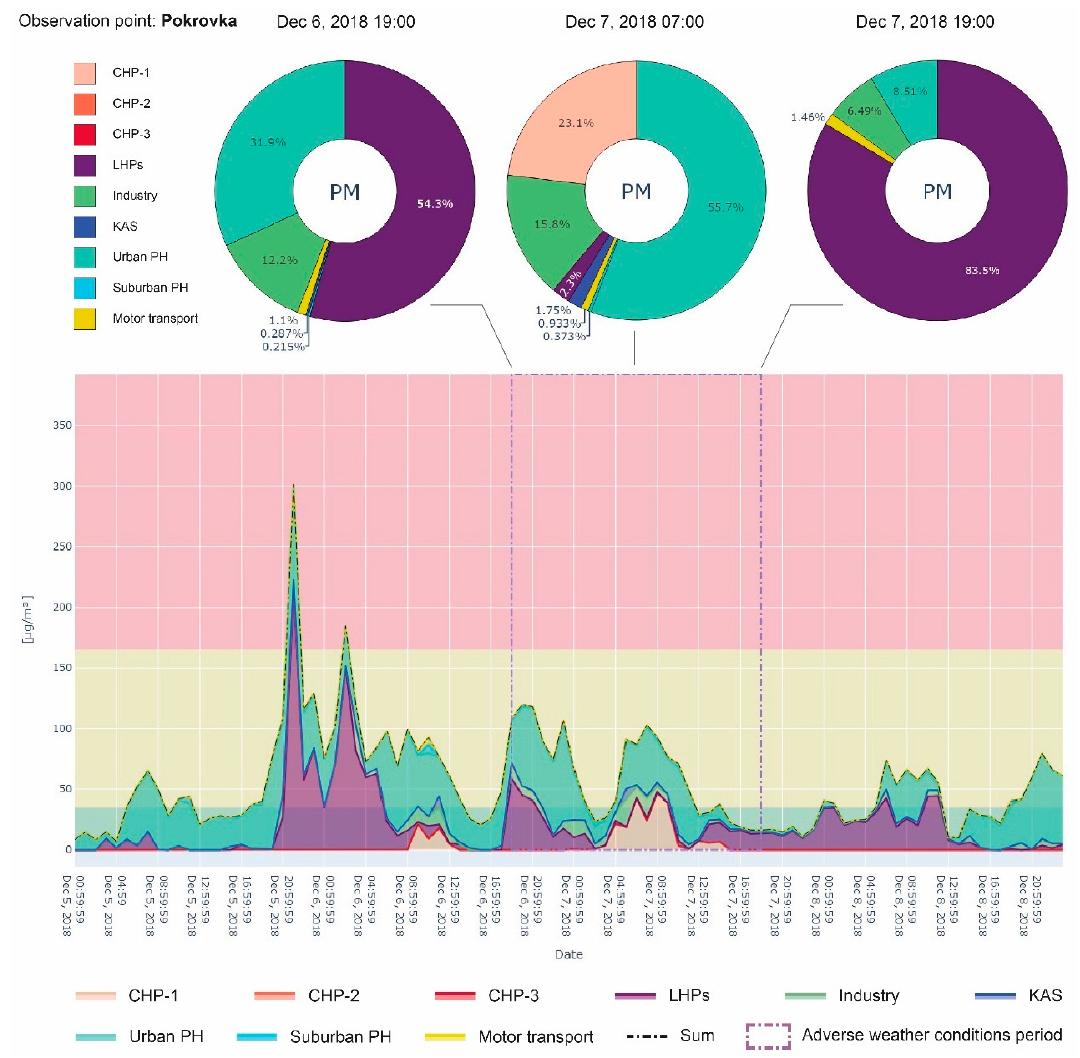
Figure 15. Simulated contributions of the main groups of emission sources in air pollution of PM at 2 m height above the ground in the cells corresponding to the Pokrovka observation point.